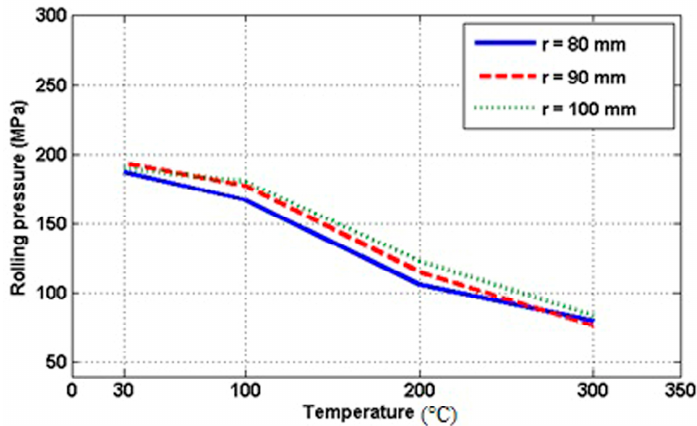
Figure 9. Maximum stress exerted on the bimetal strips with 20% of thickness reduction ratio at different roll diameters and rolling temperatures.